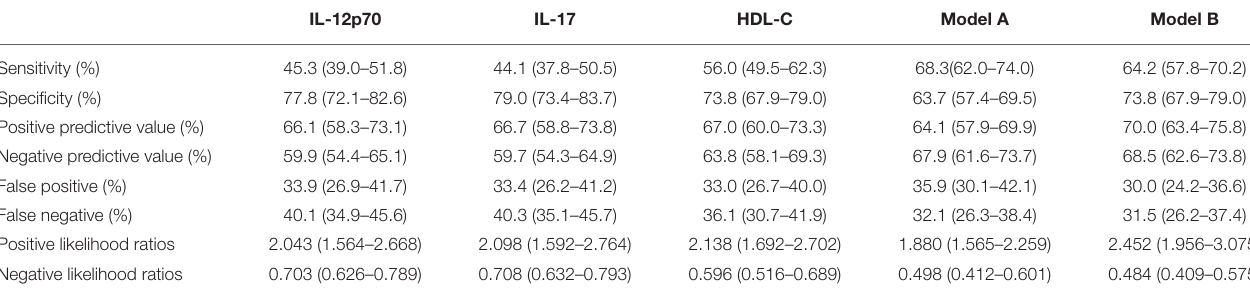
TABLE 3 | Diagnosis accuracy assessment of IL-12p70, IL-17, HDL-C and their combination in predicting severe CAD.